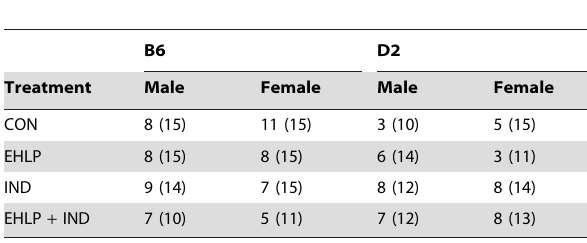
Table 1. Observations used for analyses and number of animals tested.